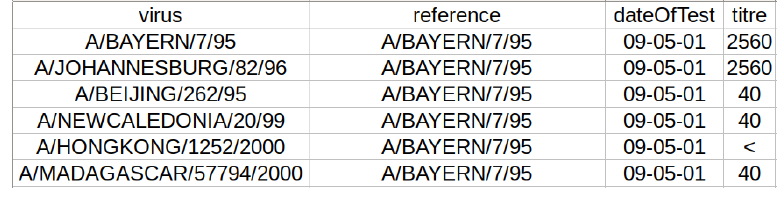
Figure 2. Each HI assay entry includes identifiers of the test and reference viruses, date of experiment, and the measured titer.